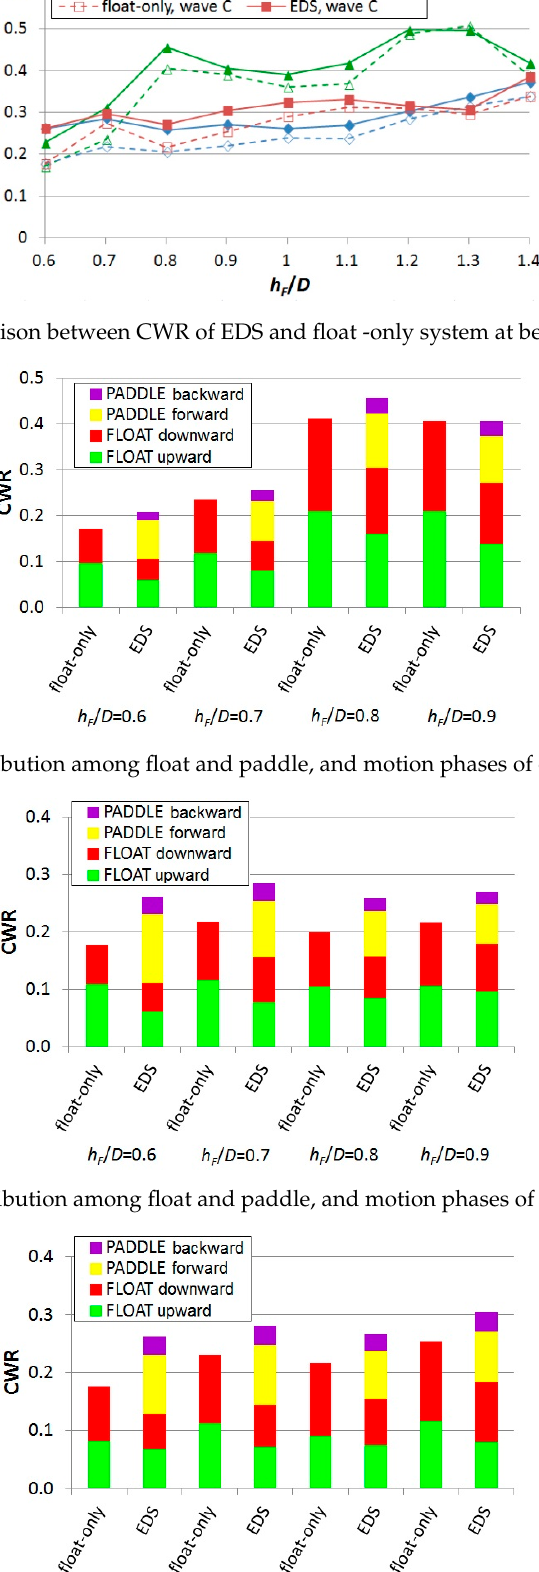
Figure 17. CWR distribution among float and paddle, and motion phases of each body. Wave C.